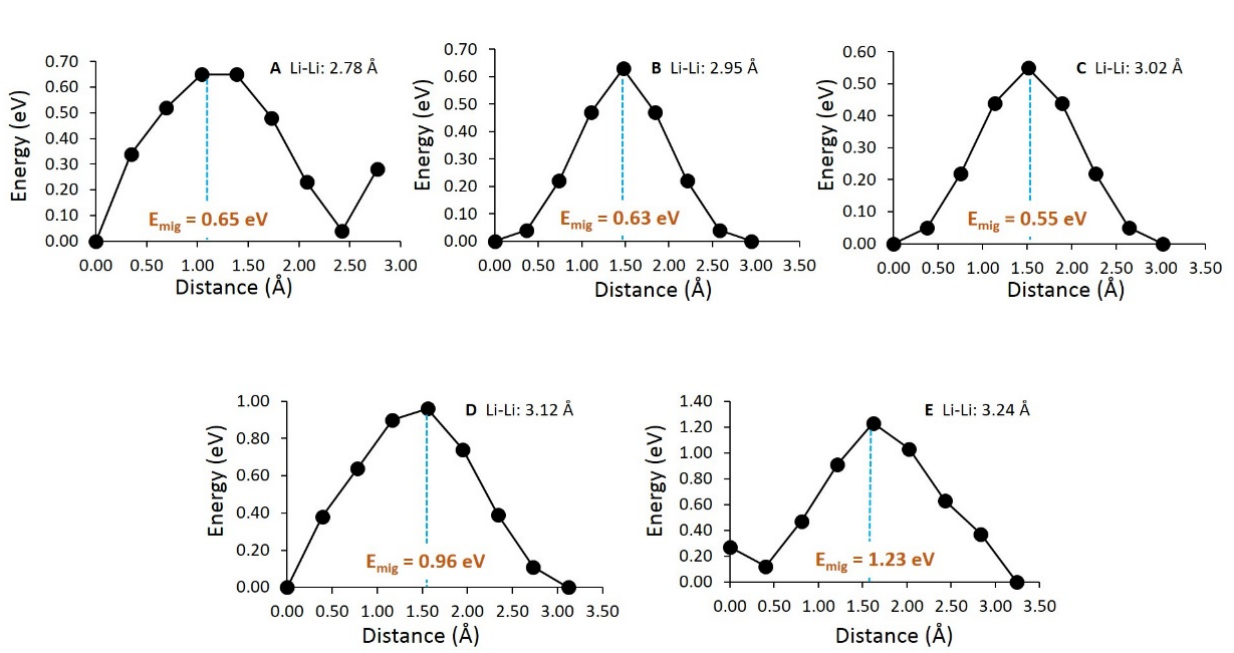
Figure 2. Li-ion diffusion pathways. Green, yellow, blue, grey and pink color atoms correspond to different Li hops.